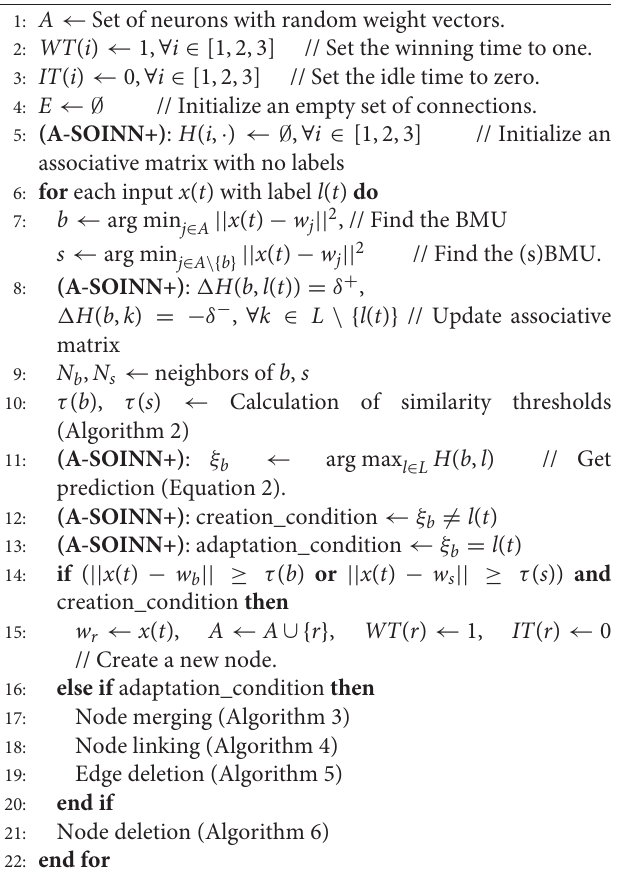
Algorithm 1 . (Associative) Self-Organizing Incremental Neural Network +